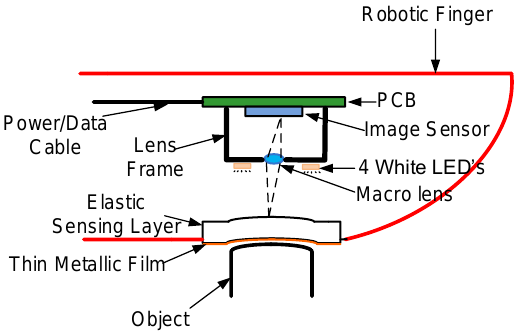
Figure 1. Optical tactile sensor architecture (conceptual).